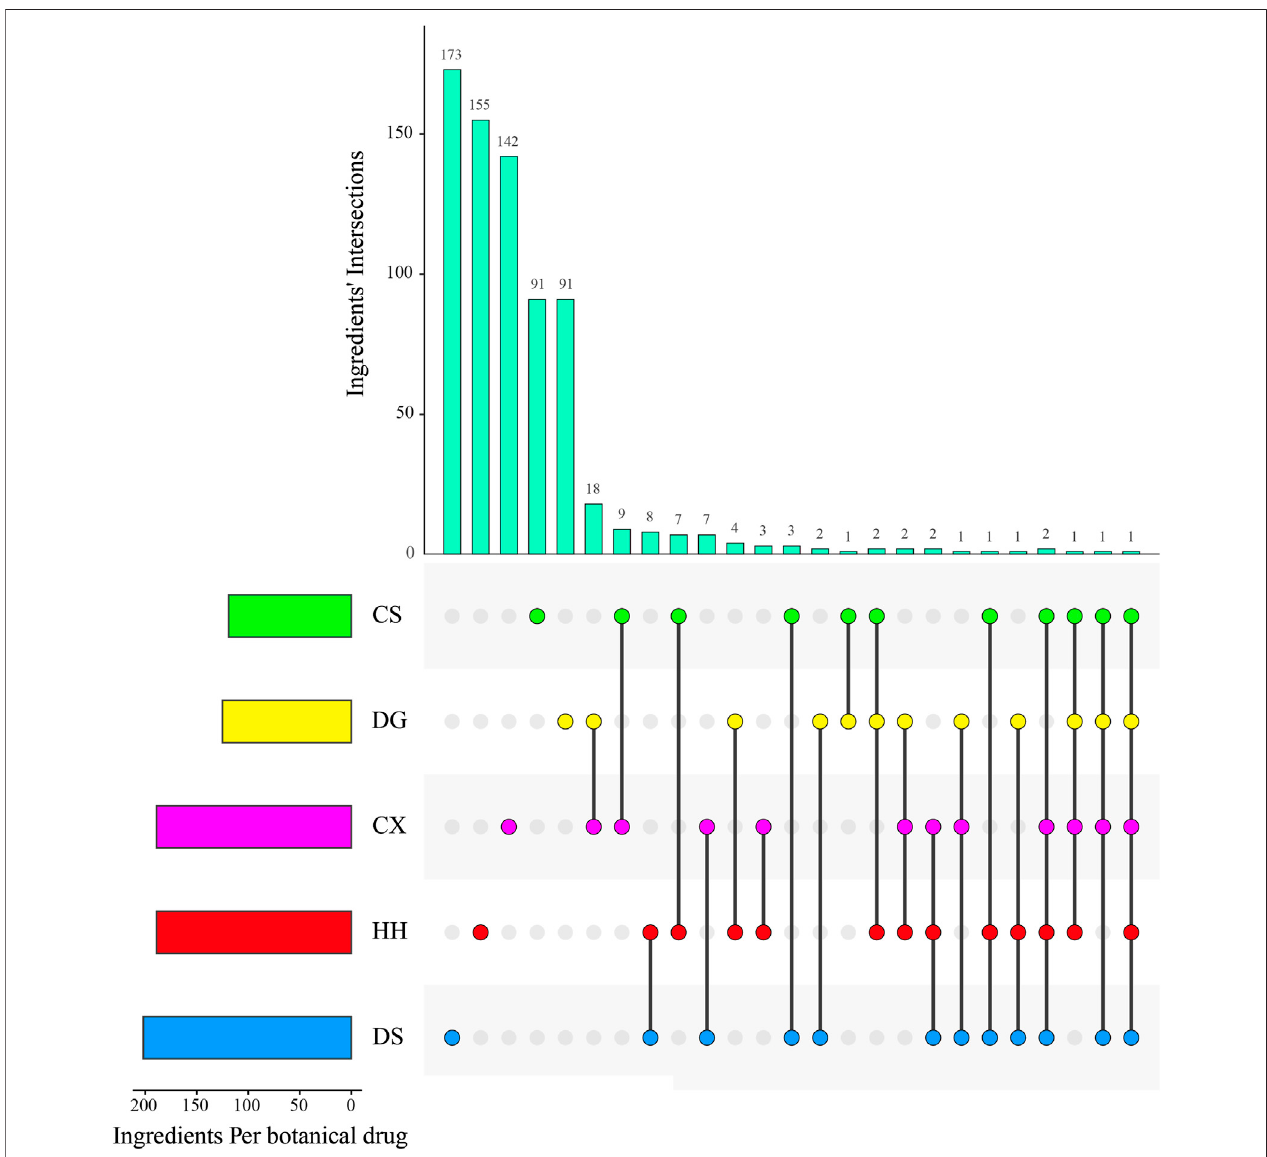
FIGURE 4 | Ingredients ’ intersections of botanical drugs in XBJI.